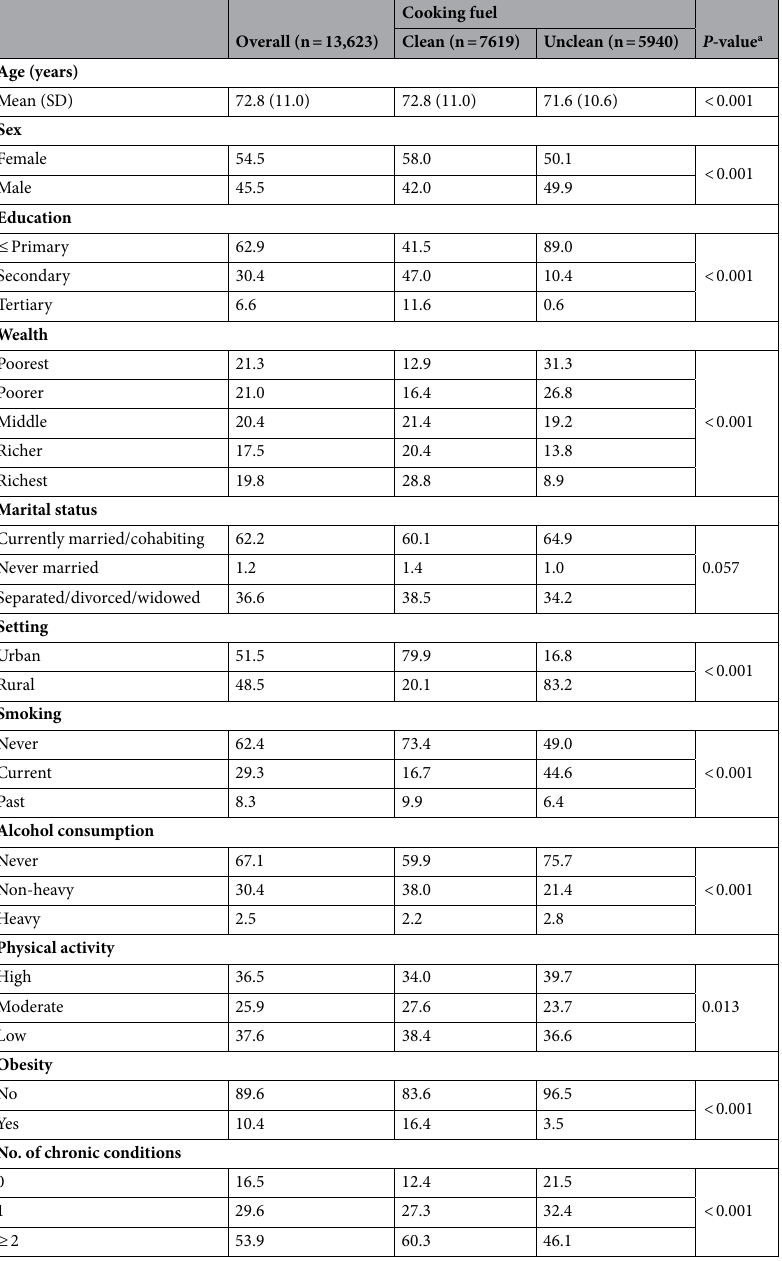
Table 1. Sample characteristics (overall and by cooking fuel). Data are % unless otherwise stated. SD standard deviation. a P -value was calculated based on Chi-squared tests and Student’s t -tests for categorical and continuous variables,